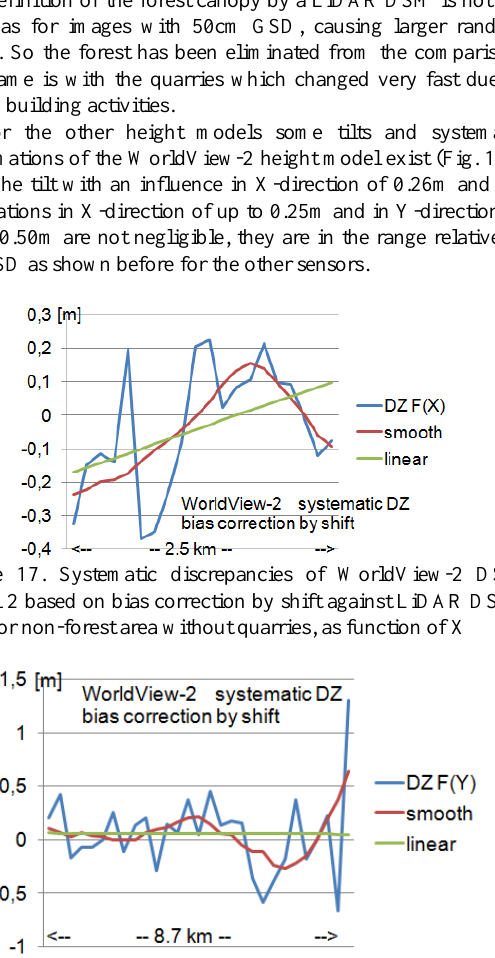
Figure 18. Systematic discrepancies of WorldView-2 DSM model 2 based on bias correction by shift against LiDAR DSM; only for non-forest area without quarries, as function of Y